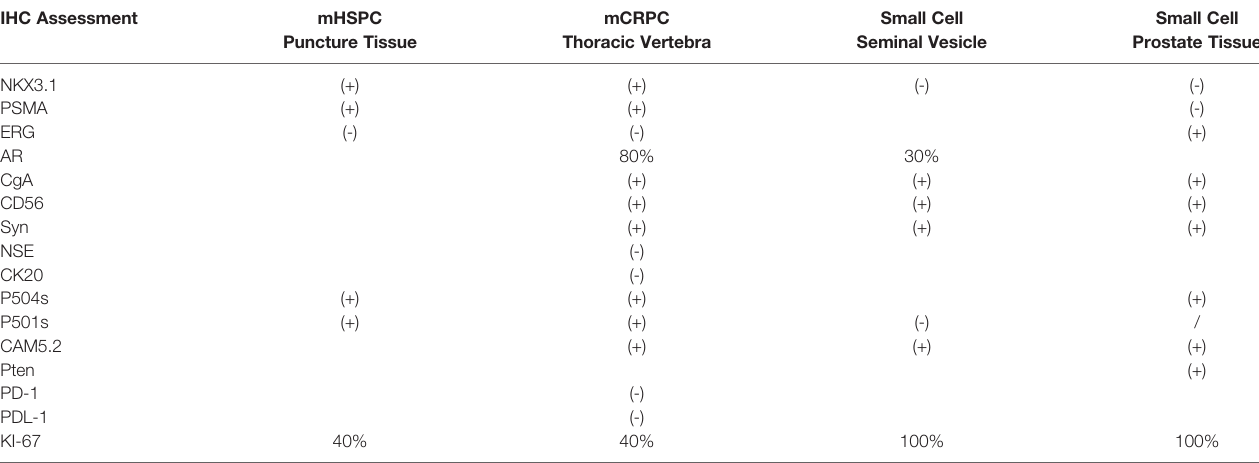
TABLE 1 | Immunohistochemical (IHC) assessment of puncture tissue of prostate, thoracic vertebral biopsy specimen, seminal vesicle tissue, and prostate after transurethral resection of prostate